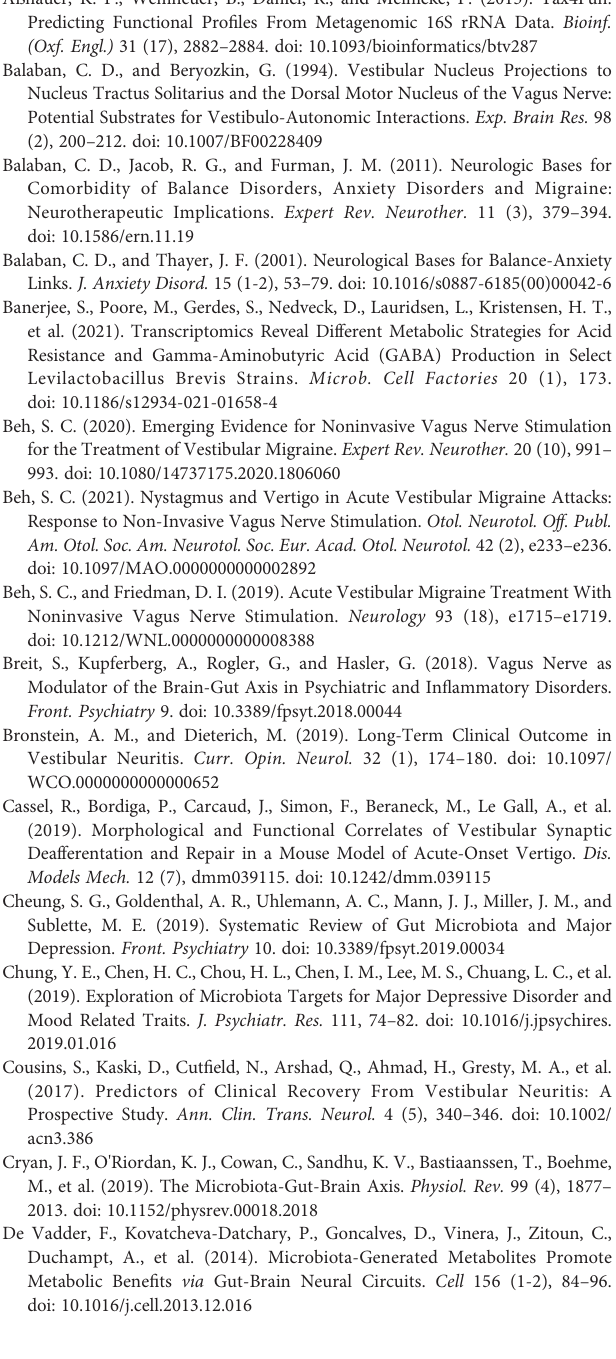
Supplementary Figure 4 | Volcano plot showing differential metabolites between the CON and SS groups (A) . Linear discriminant analysis (LDA) effect size (LEfSe) results showed the top 20 differential metabolites between the CON and SS groups (B) . Hierarchical cluster analysis of differential metabolites between the CON and SS groups (C) . Each column represents a sample and each row stands for a metabolite. The differential metabolites were identi fi ed using the following criteria: variable importance in projection (VIP) ≥ 1.0, p-value